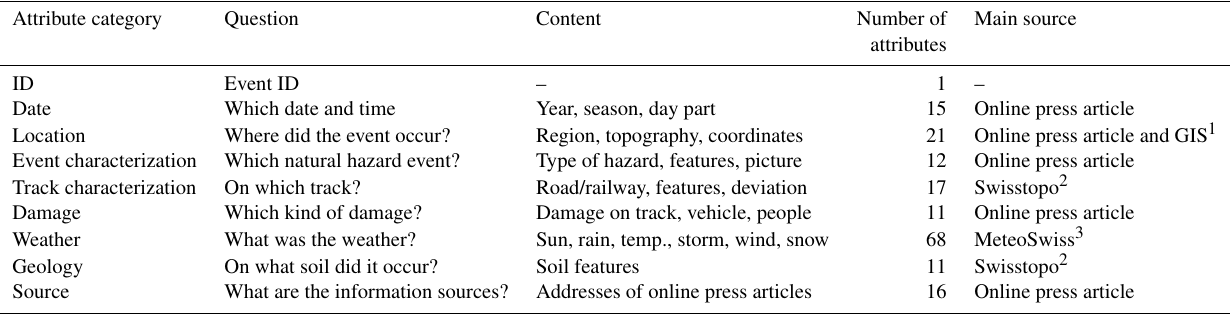
Table 1. Attribute categories describing events in the